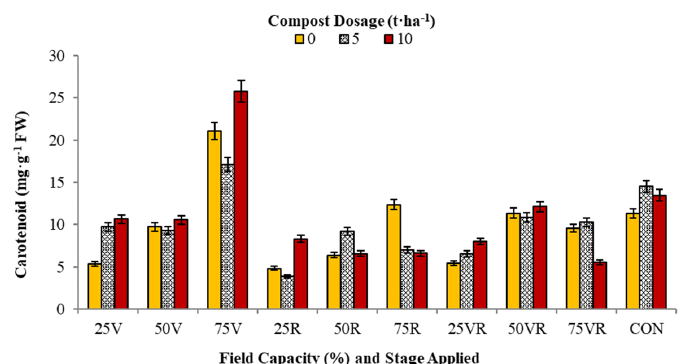
Figure 16. Effect of interaction of water regime, treatment stage and compost dosage on carotenoid content of okra leaf at 8 weeks The 25, 50 and 75% represent field capacity; V (vegetative), R (reproductive), and VR (vegetative and reproductive) represent the stage at which the deficit was applied. Data in the interaction analysed with Least Squares Means, and means separated with LSD.